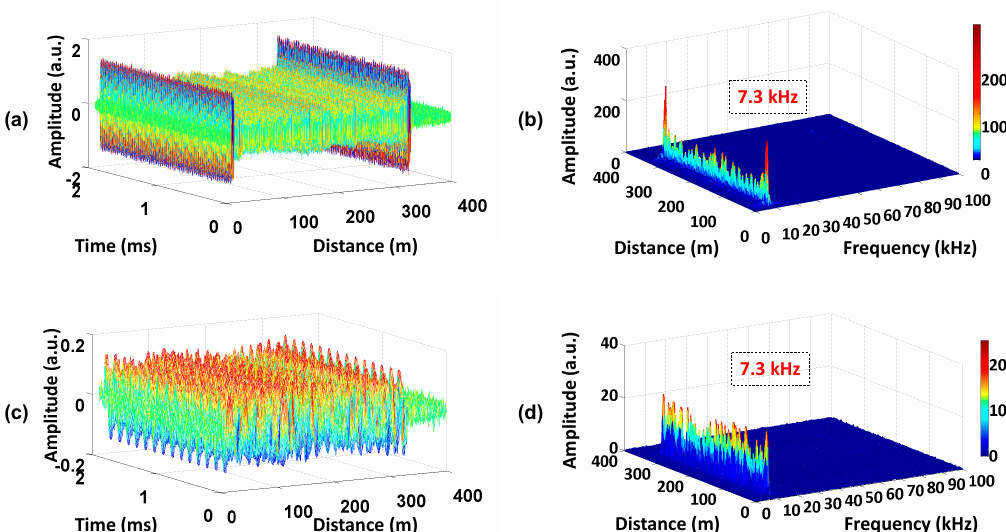
Figure 8. The variation frequency of the beat signal. ( a ) The traces of the beat signal at different periods and ( b ) the power spectrum along the sensing fiber; ( c ) The traces at different periods and ( d ) the power spectrum along the sensing fiber after mixing a cosine signal with the fixed frequency.